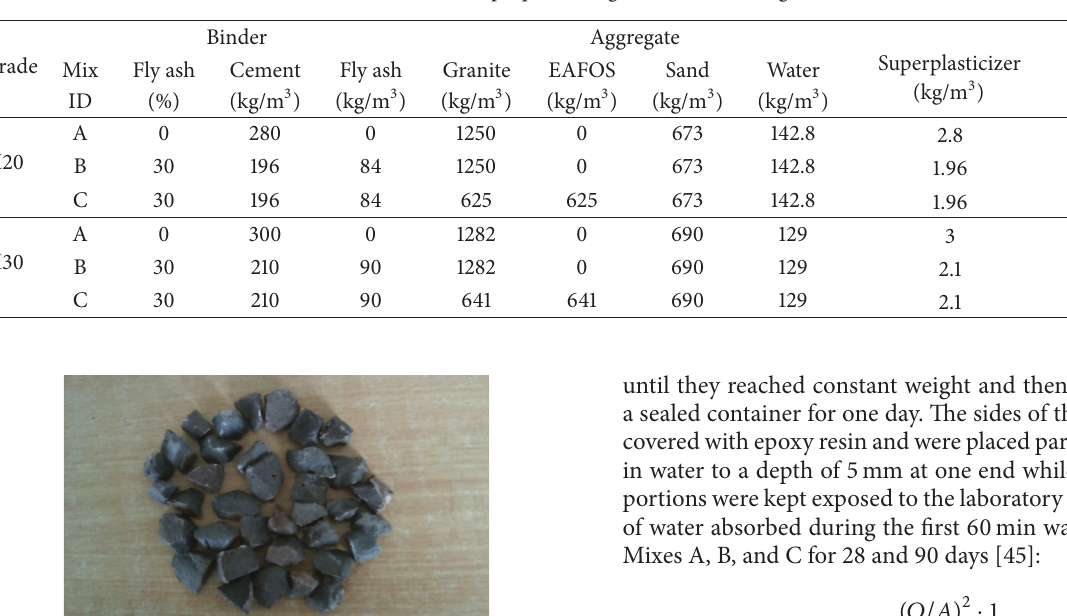
Table 2: Mix proportioning of M20 and M30 grade.